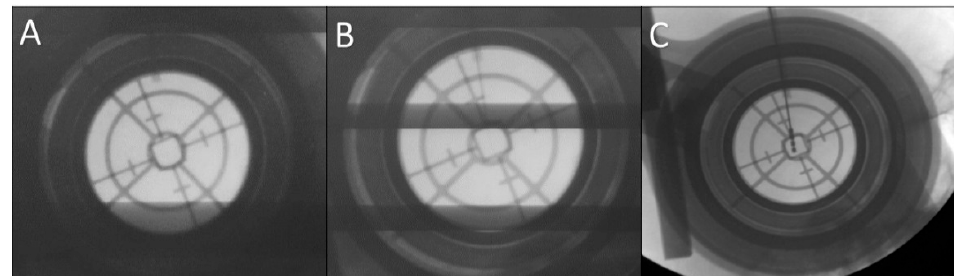
Figure 11. Fluoroscopic confirmation of the target approach. ( A ) Confirmation of the position of the stereotactic cannula; ( B ) the microelectrode is advanced to the target under fluoroscopic guidance; ( C ) the final position of the deep brain stimulation electrode confirmed.